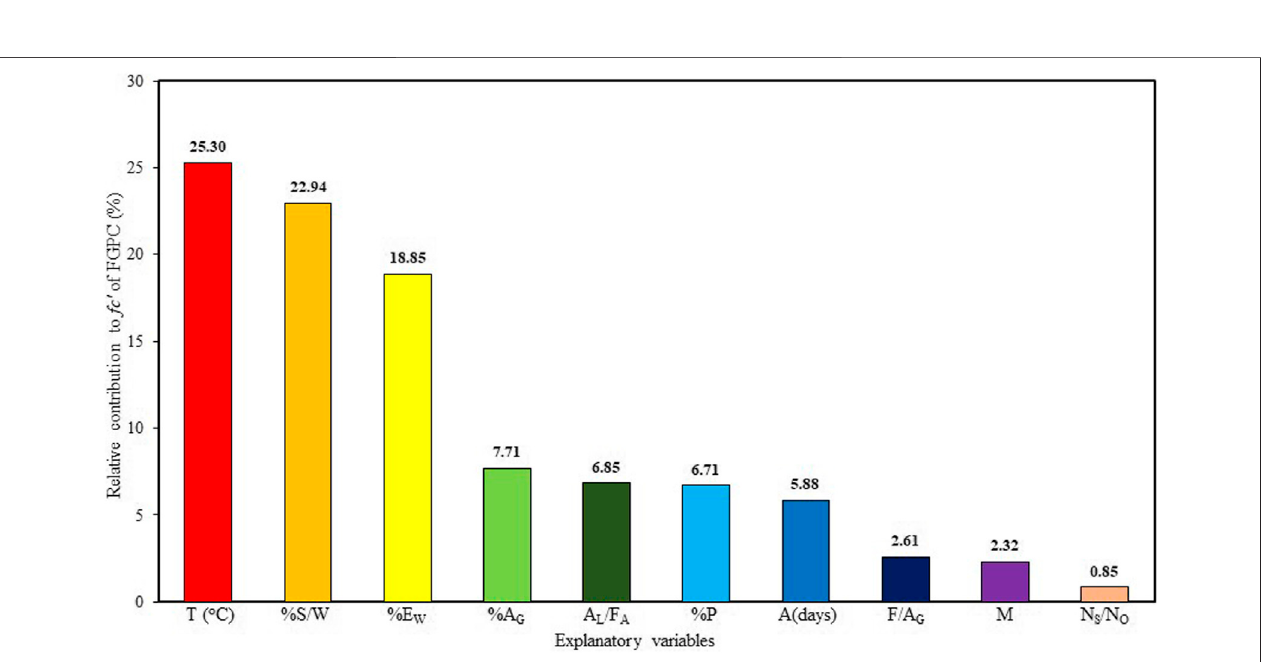
FIGURE 11 | Percentage of the comparative contribution of input